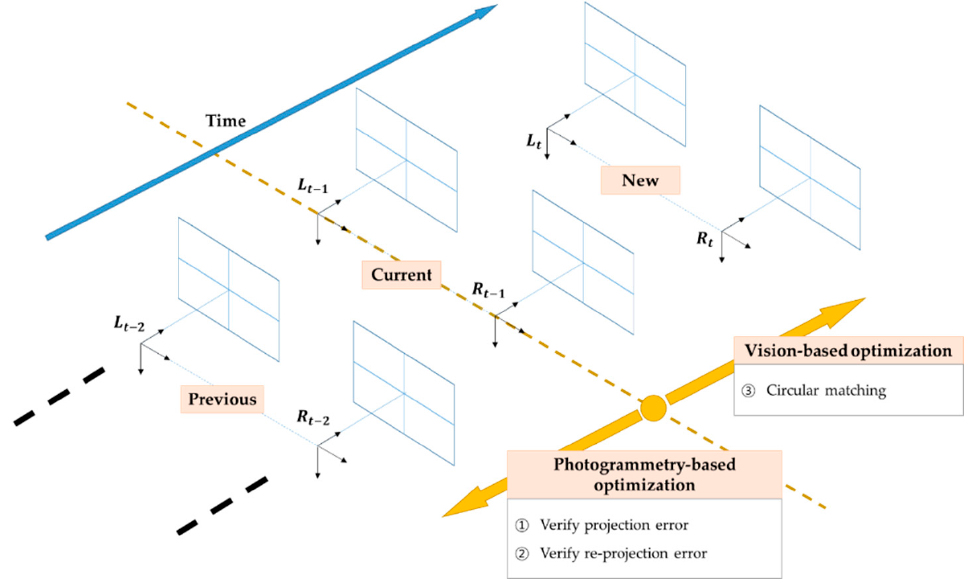
Figure 4. Feature optimization concept diagram.